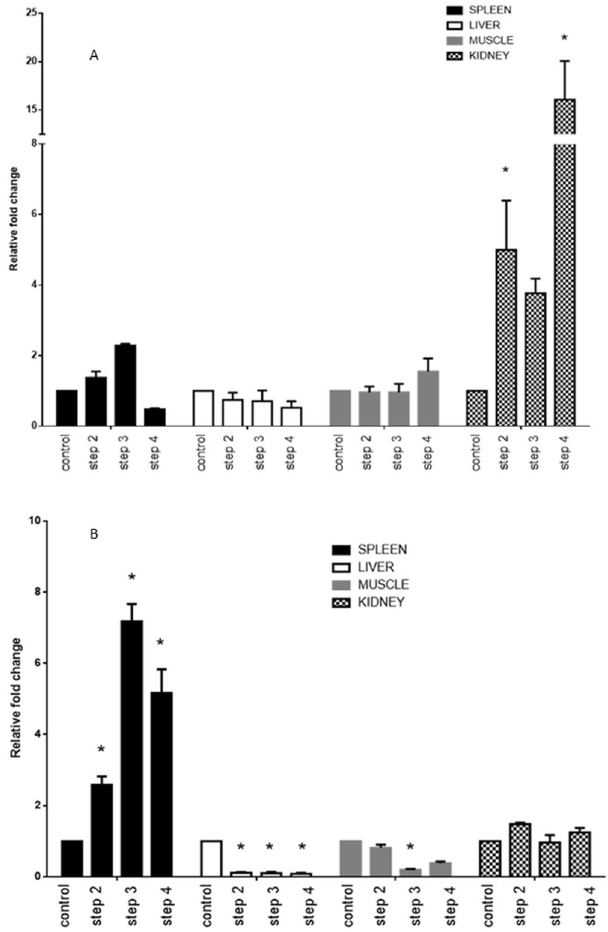
Figure 4. Relative expression of ssa-miR-193-5p utilizing selected candidate reference genes; 18S rRNA for normalization ( A ) and ssa-miR-23a-3p and ssa-miR-99-5p ( B ) * p <